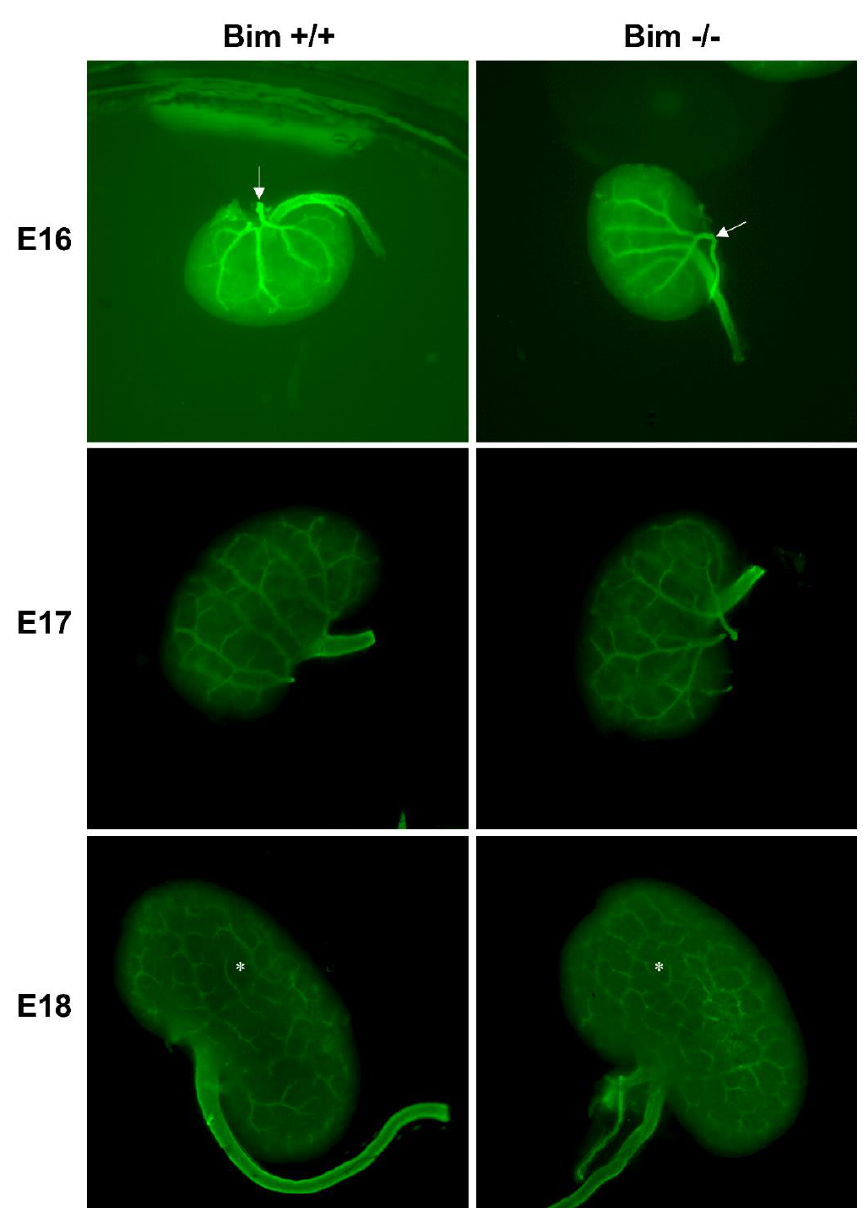
Figure 7. Increased capillary loops at E18 in Bim −/− mice. Kidneys from E16 – 18 embryos were wholemount stained for α -SMA to visualize the renal vasculature. Images are taken at 20× magnification. Please note Bim +/+ and Bim −/− mice are littermates. At E16 arrow points to primary bifurcation of the renal artery. At E18 the asterisk denotes subcapsular vascular network. Data representative of six mice.